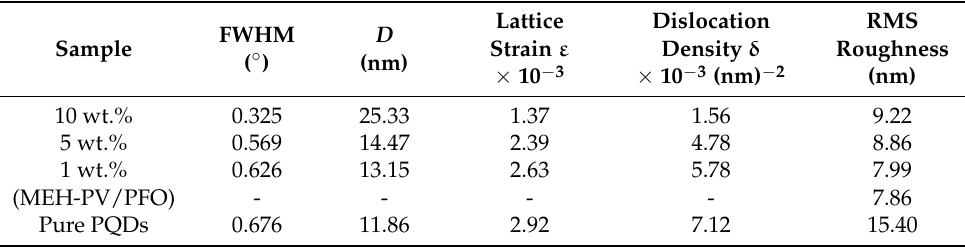
Table 1. Structural properties of the MEH–PPV/PFO hybrid, CsPbBr 3 -PQDs, and PQDs/(MEH– PPV/PFO) composite thin films.